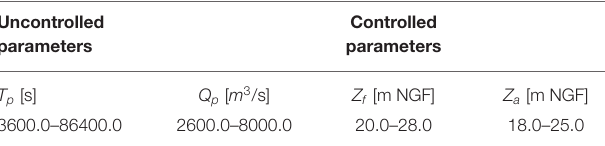
TABLE 1 | Qualified parameters of the study: time to peak discharge T p , peak discharge rate Q p , dyke elevation Z f , slab elevation Z a